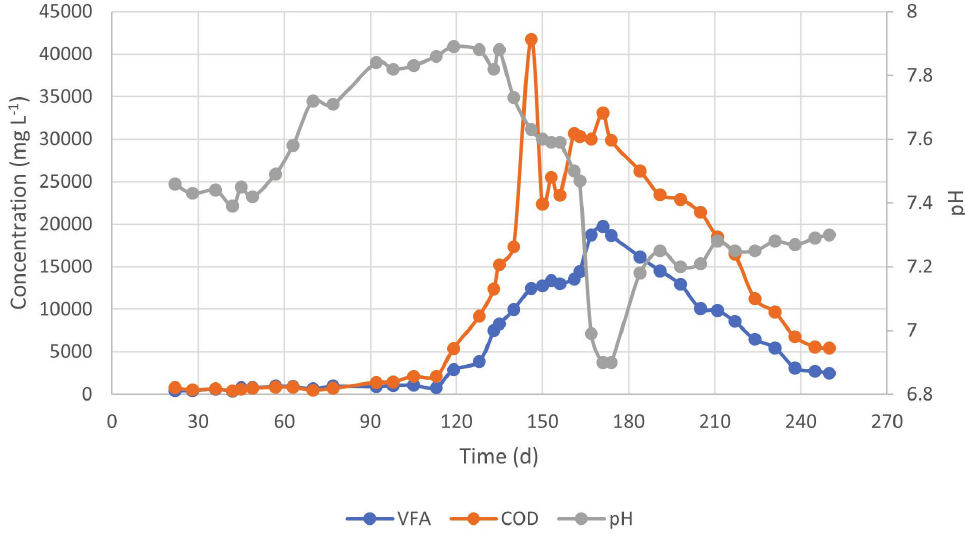
Fig. 5 – Volatile fatty acids (VFA) and chemical oxygen demand (COD) concentration and pH